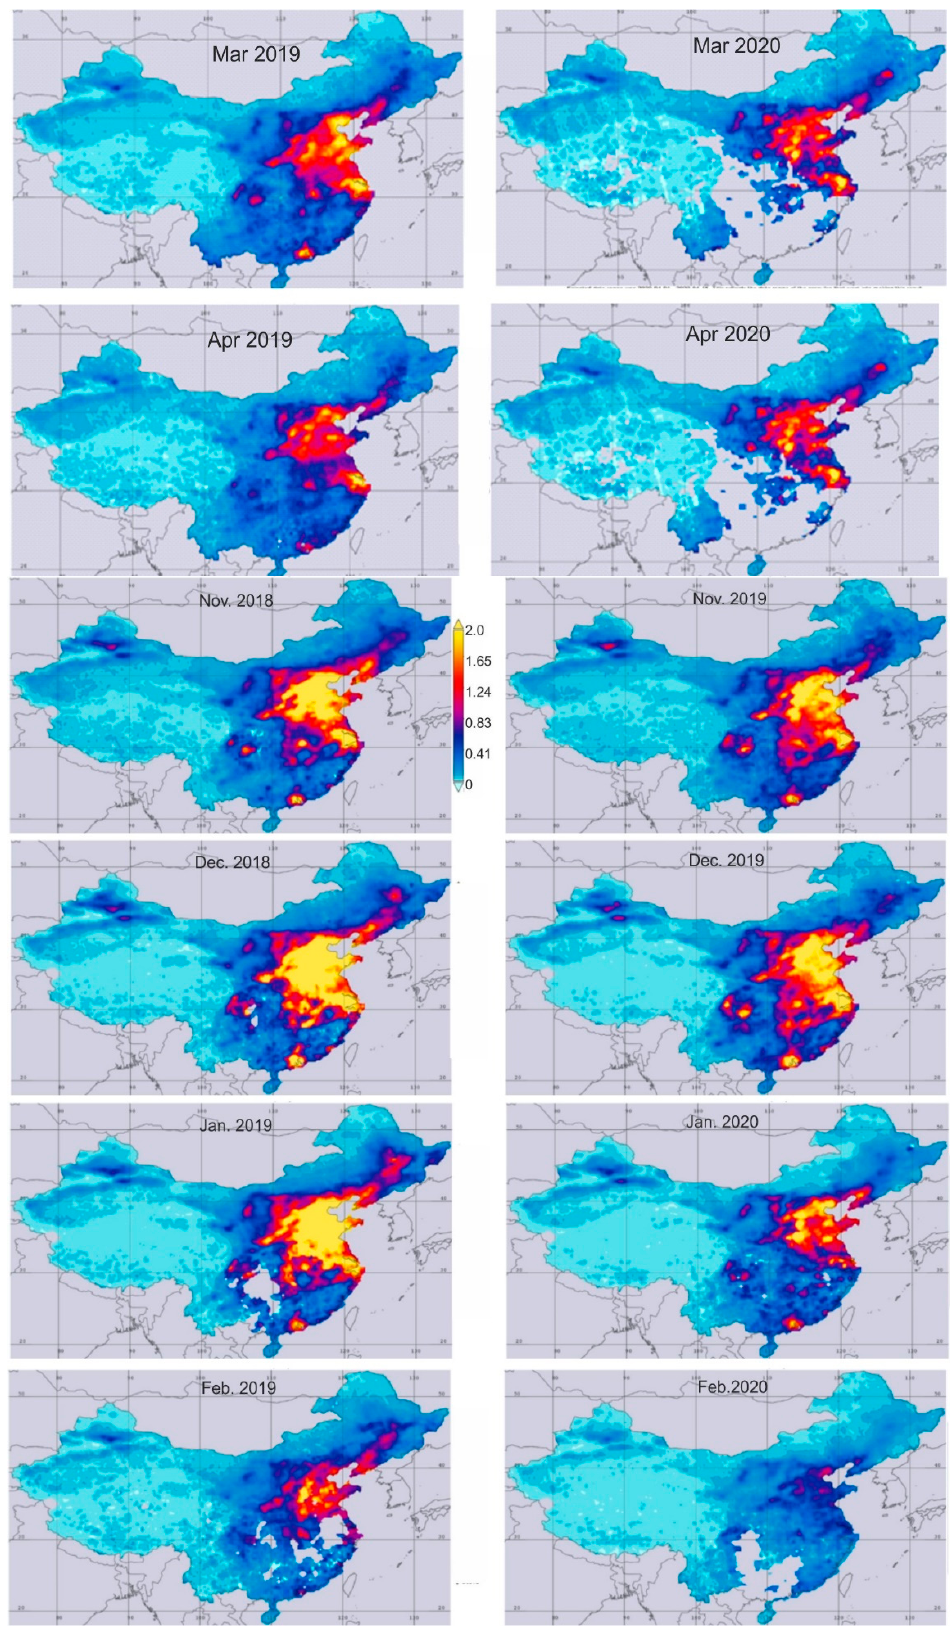
Figure 3. OMI-based monthly mean tropospheric NO 2 (10 15 molec/cm − 2 ), from November 2018 to April